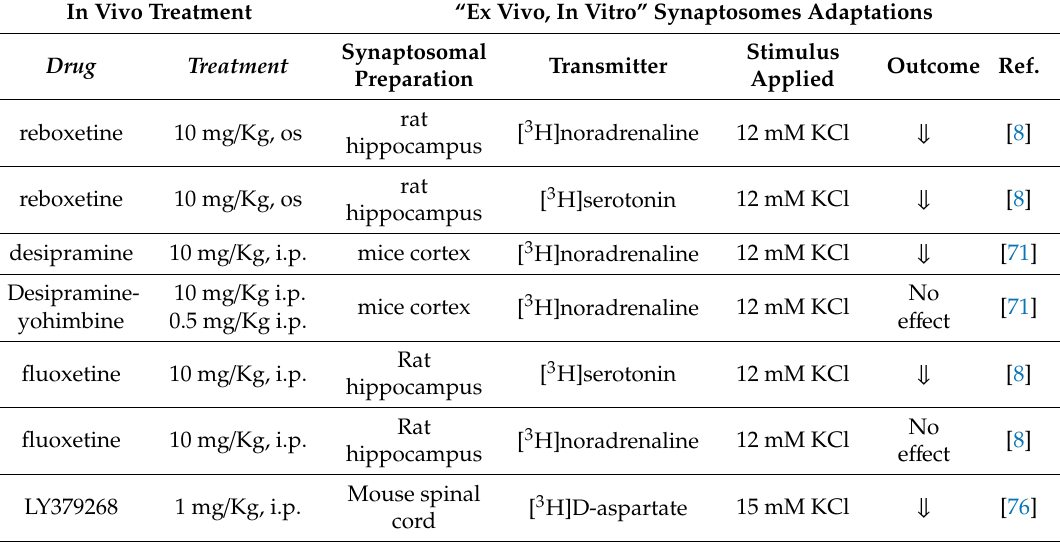
Table 2. “ex vivo, in vitro” persistent “presynaptic adaptation” in synaptosomes. In Vivo Treatment “Ex Vivo, In Vitro” Synaptosomes